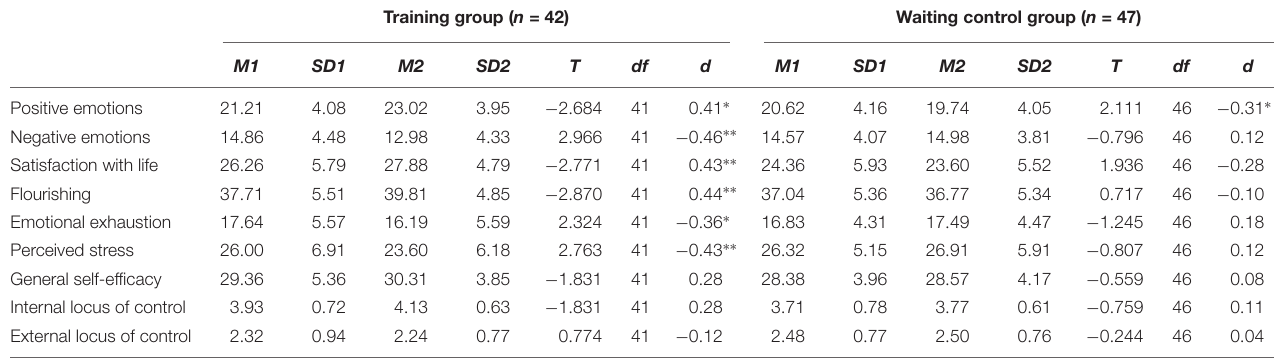
TABLE 3 | Within-group training effects 1 day after training (pre–post).